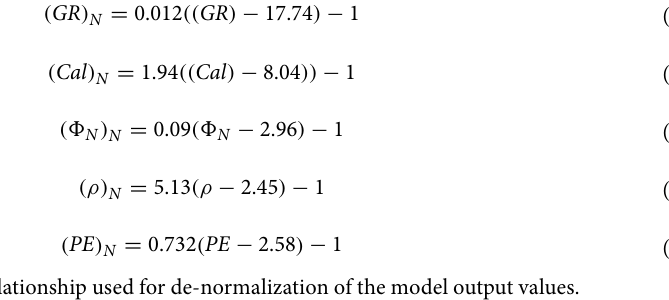
Equation (17) showing the relationship used for de-normalization of the model output values.